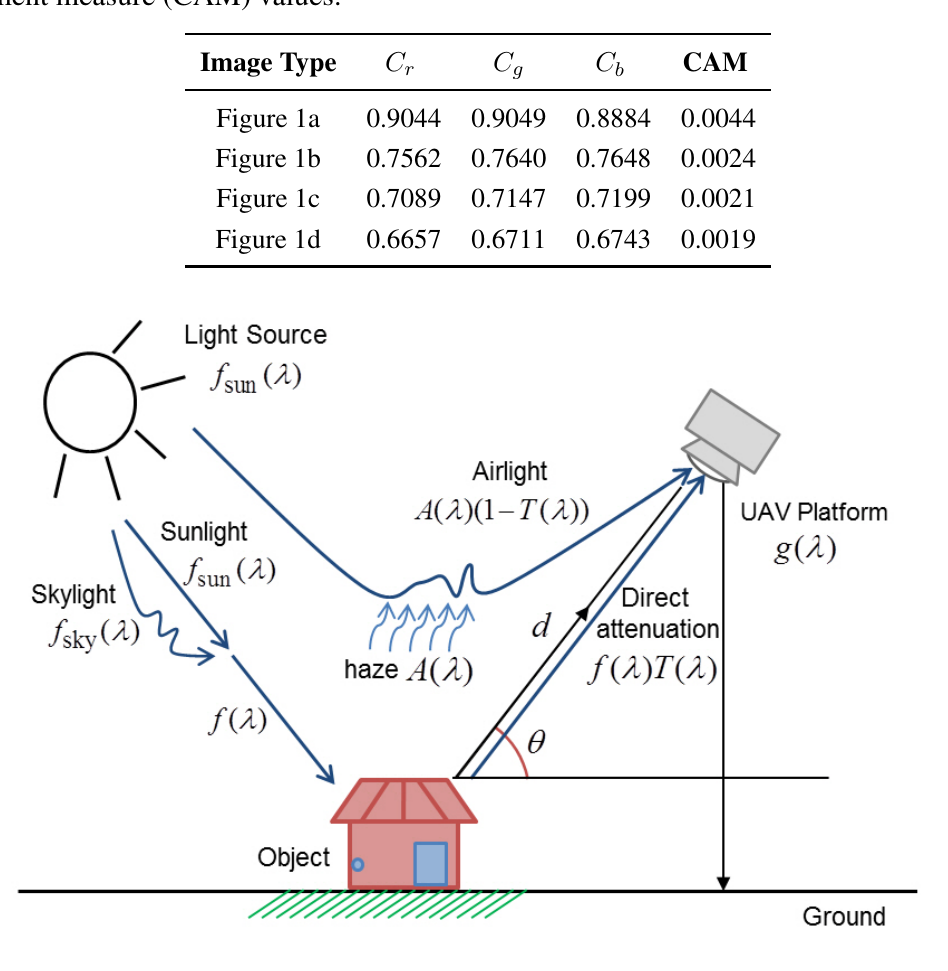
( λ ) and f ( λ ) respectively represent the sun sky ( λ ) represents the light component that is scattered sky